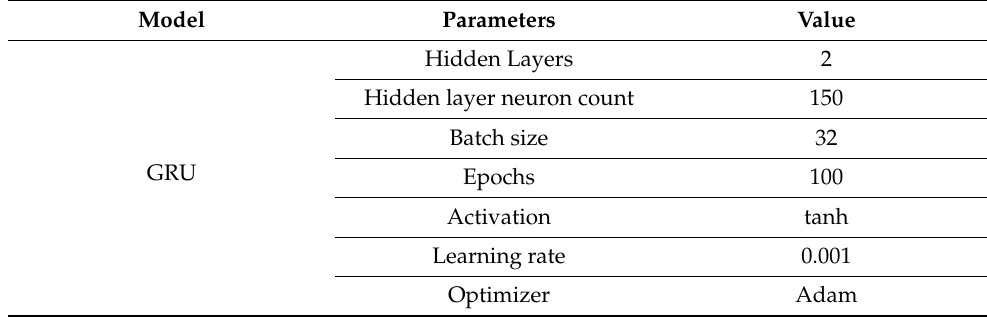
Table 4. Hyperparameters of GRU